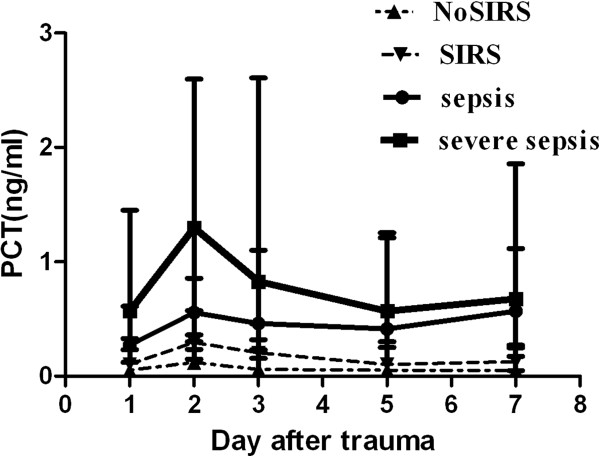
Course of procalcitonin (PCT) in patients who developed various stages of severe sepsis, sepsis, systemic inflammatory response syndrome (SIRS), or NoSIRS (median, quartiles).